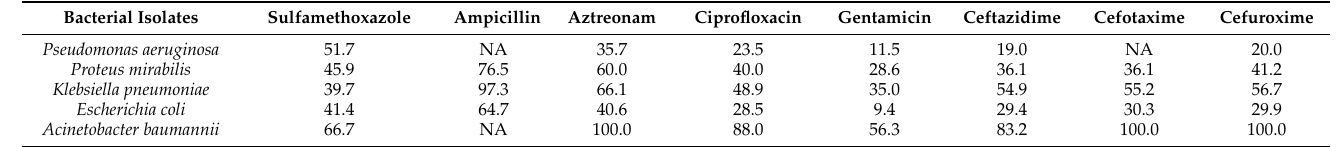
Table 4. Gram-negative bacterial resistance rates in patients aged less than 48